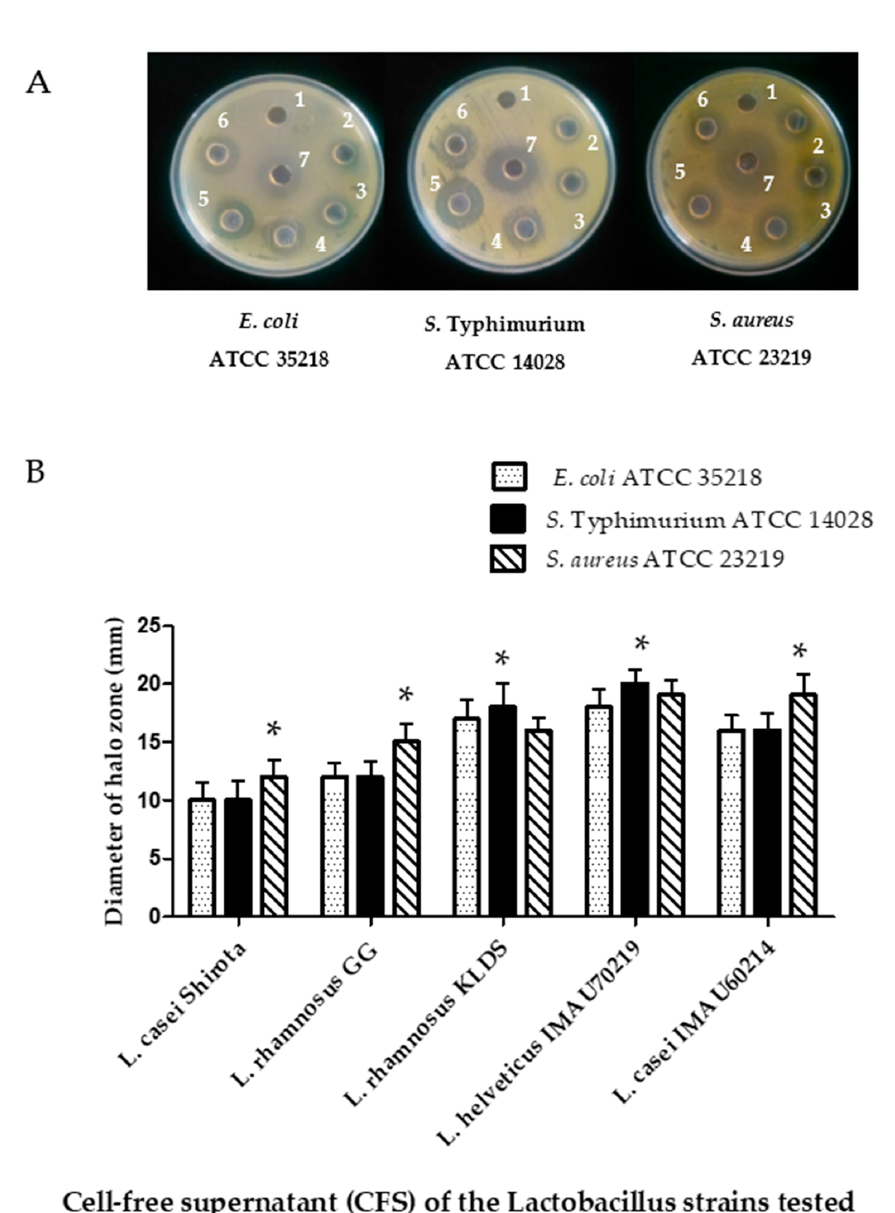
Figure 6. Antimicrobial activity of cell-free supernatant (CFS) of Lactobacillus strains against pathogenic bacteria. ( A ) Well 1, control MRS (alone) or negative (not-inhibitory); Well 2, L. rhamnosus GG; Well 3, L . rhamnosus KLDS; Well 4, L . helveticus IMAU70129; Well 5, L. casei IMAU60214; Well 6, L. casei strain Shirota; Well 7, MRS with tetracycline antibiotic (positive showed inhibitory activity). ( B ) Zone inhibition in diameter (mm). Values represent the mean ± SD of three different assays. * significant difference among Lactobacillus strains ( p < 0.05).